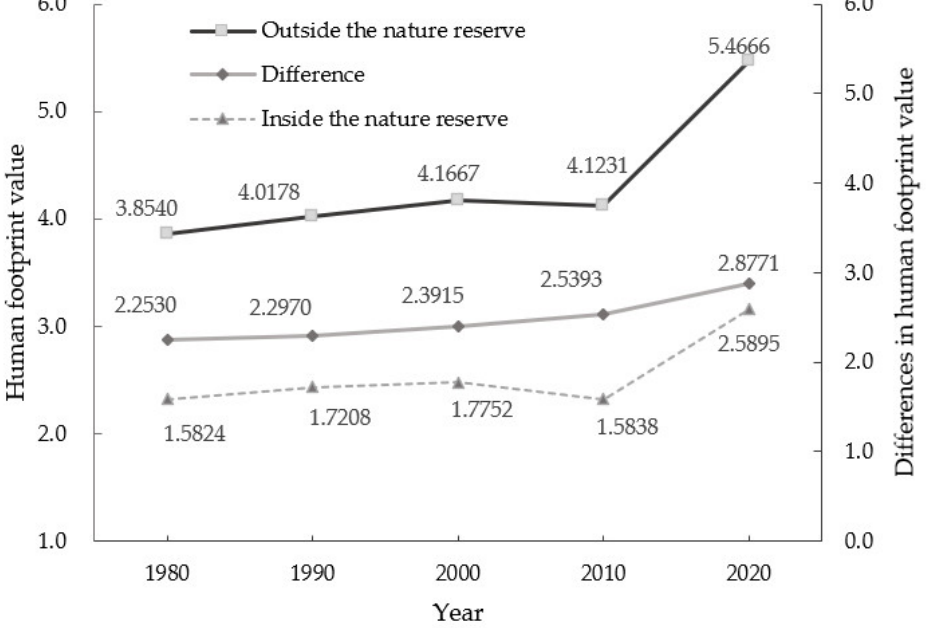
Figure 2. Comparative analysis of human footprint value between inside and outside of the Qilian Mountain Nature Reserve.